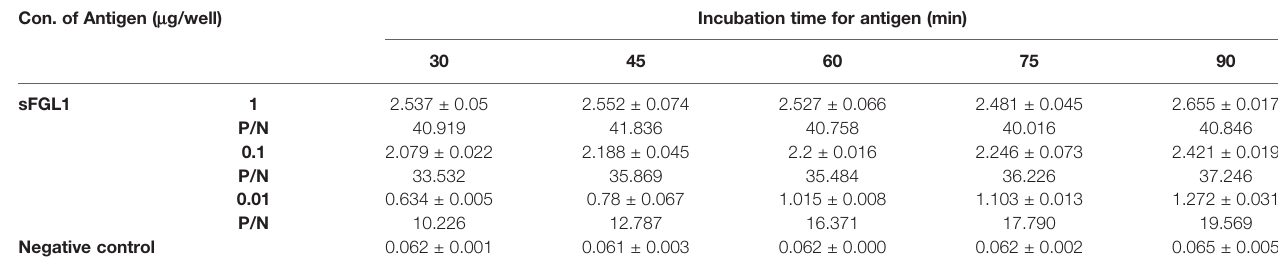
TABLE 4 | Determination of the optimal incubation time for samples.